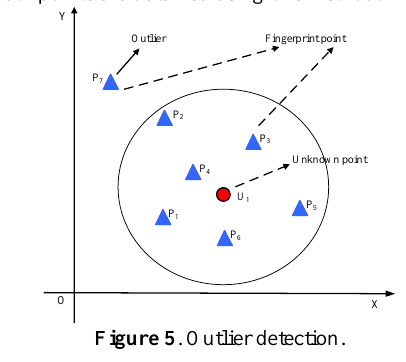
Figure 5 . Outlier